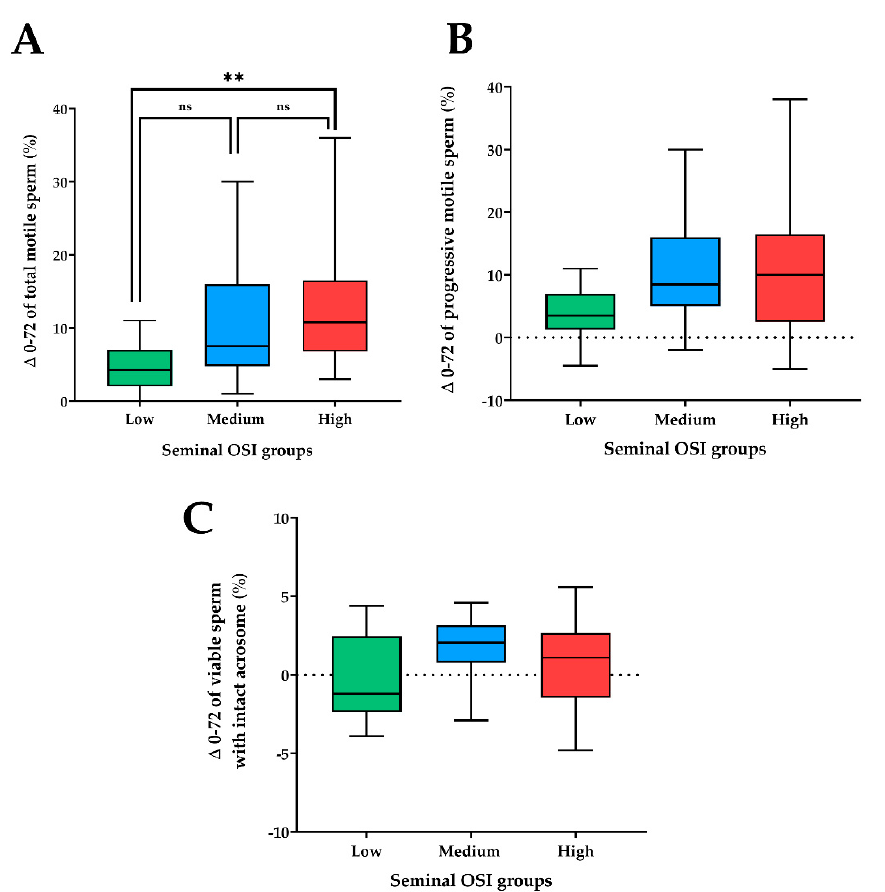
Figure 2. Box-whisker plot showing the differences (sperm resilience) in the percentages of ( A ) total motile sperm; ( B ) progressive motile sperm; and ( C ) viable sperm with intact acrosome between both evaluation time-points (0 and 72 h of storage at 17 °C) of artificial insemination semen doses (n = 58) of boar ejaculates clustered into three groups (hierarchical clustering, p < 0.01) according to the oxidative stress index (OSI) of seminal plasma. Low seminal OSI ranged from 0.75 to 1.89 (16 semen doses), medium from 2.01 to 2.91; (22 semen doses) and high from 3.04 to 5.54 (20 semen doses). Boxes enclose the 25th and 75th percentiles, whiskers extend to the 5th and 95th percentiles and the line indicates the median. ** p < 0.001; ns: not significant. and the line indicates the median. ** p < 0.001; ns: not